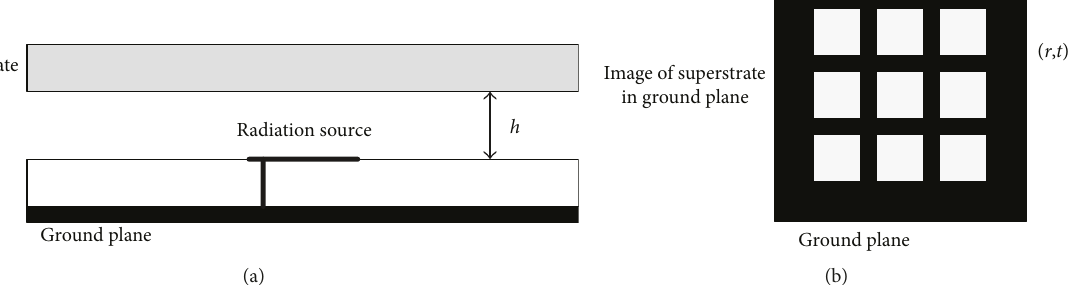
Figure 1: The schematic diagrams of (a) the FSS superstrate layer with the antenna ground plane acting as the lower plane of the EBG structure and (b) the top view of the FSS